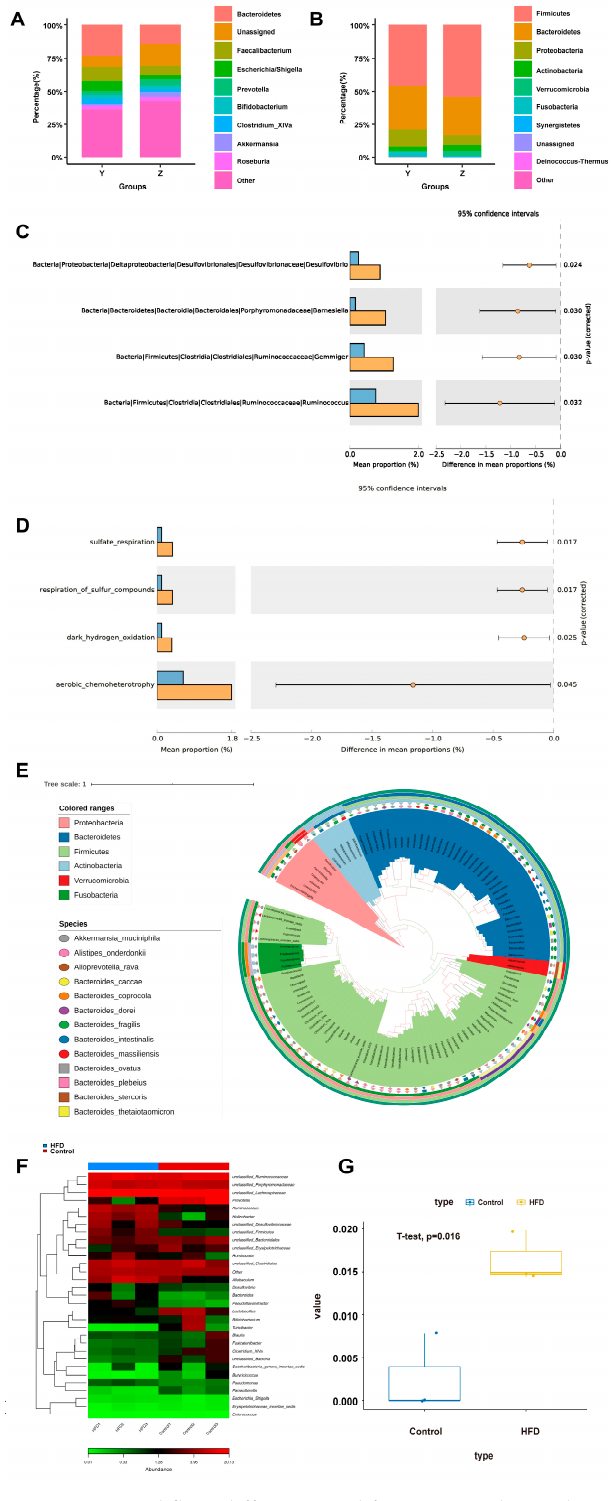
Figure 5. Faecal flora difference and function prediction between the human liver metastasis group and the non-metastatic group of colorectal cancer. ( A ) Faecal intestinal microbiota distribution at the genus level. ( B ) Faecal intestinal microbiota distribution at the phylum level. ( C ) Representa- tive intestinal microbiota with differential expression between groups. ( D ) Function prediction of Desulfovibrio . ( E ) Evolutionary Trees of species reveals that all the bacteria varied in two groups were Gram-negative. ( F , G ) Desulfovibrio is highly expressed in HFD groups at the genus level. (Y: non-metastatic group, n = 10; Z: metastatic group, n = 13). * p <